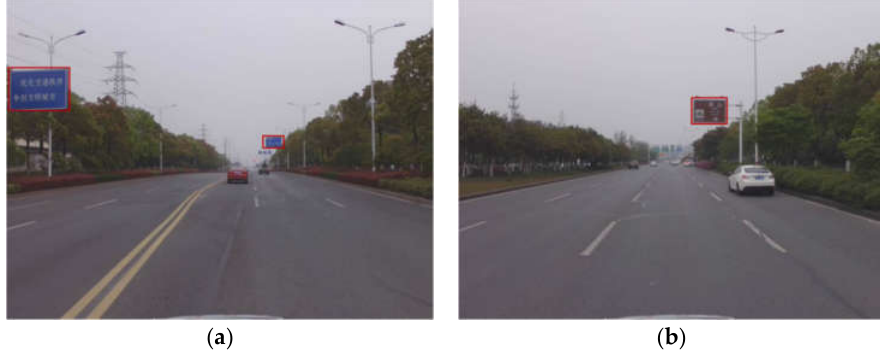
Figure 22. Detection results at sunset: ( a ) site 1; ( b ) site 2.